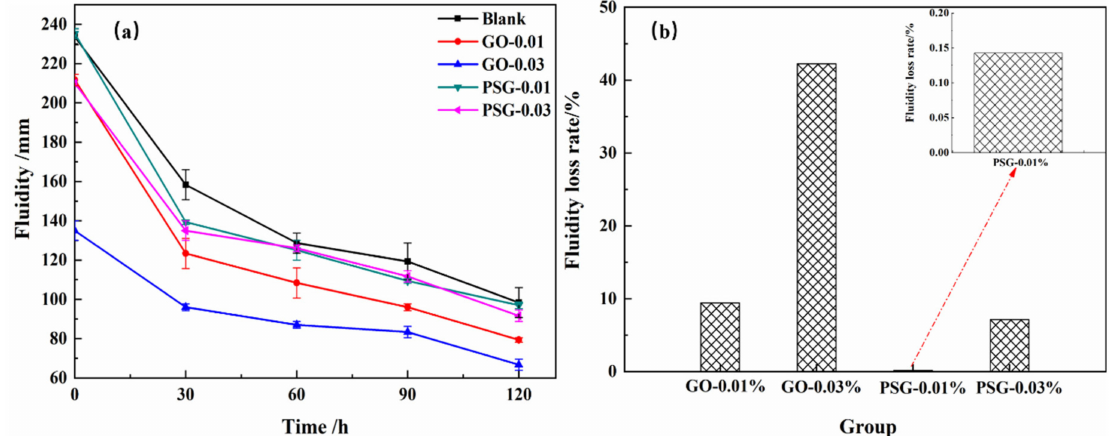
Figure 7. Results of cement paste fluidity test: ( a ) time dependency of fluidity; and ( b ) initial fluidity loss-rate of cement paste.